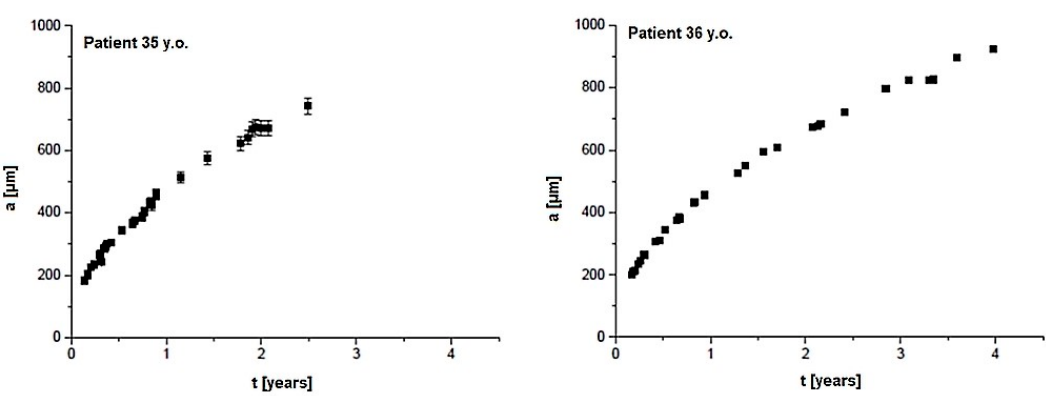
Figure 6. The dependence of the radius value of mineral grains built from HAP from the growth time for two cases of the yellow ligaments young patients (control group) .